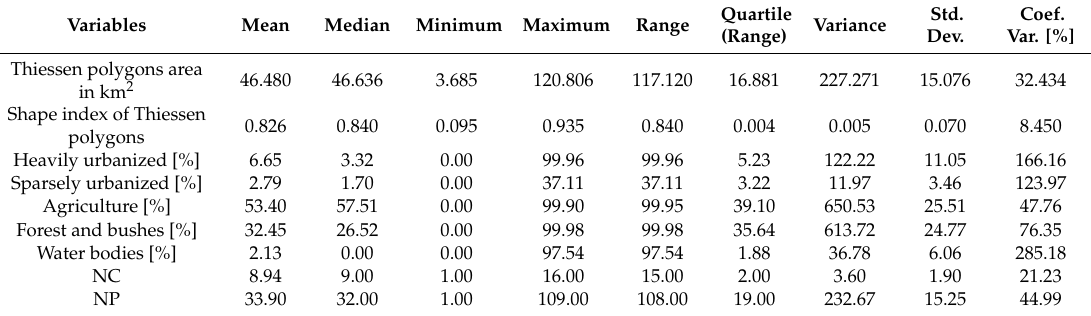
Table 4. Morphology and land cover characteristics of Thiessen polygons (confidence level 95%).